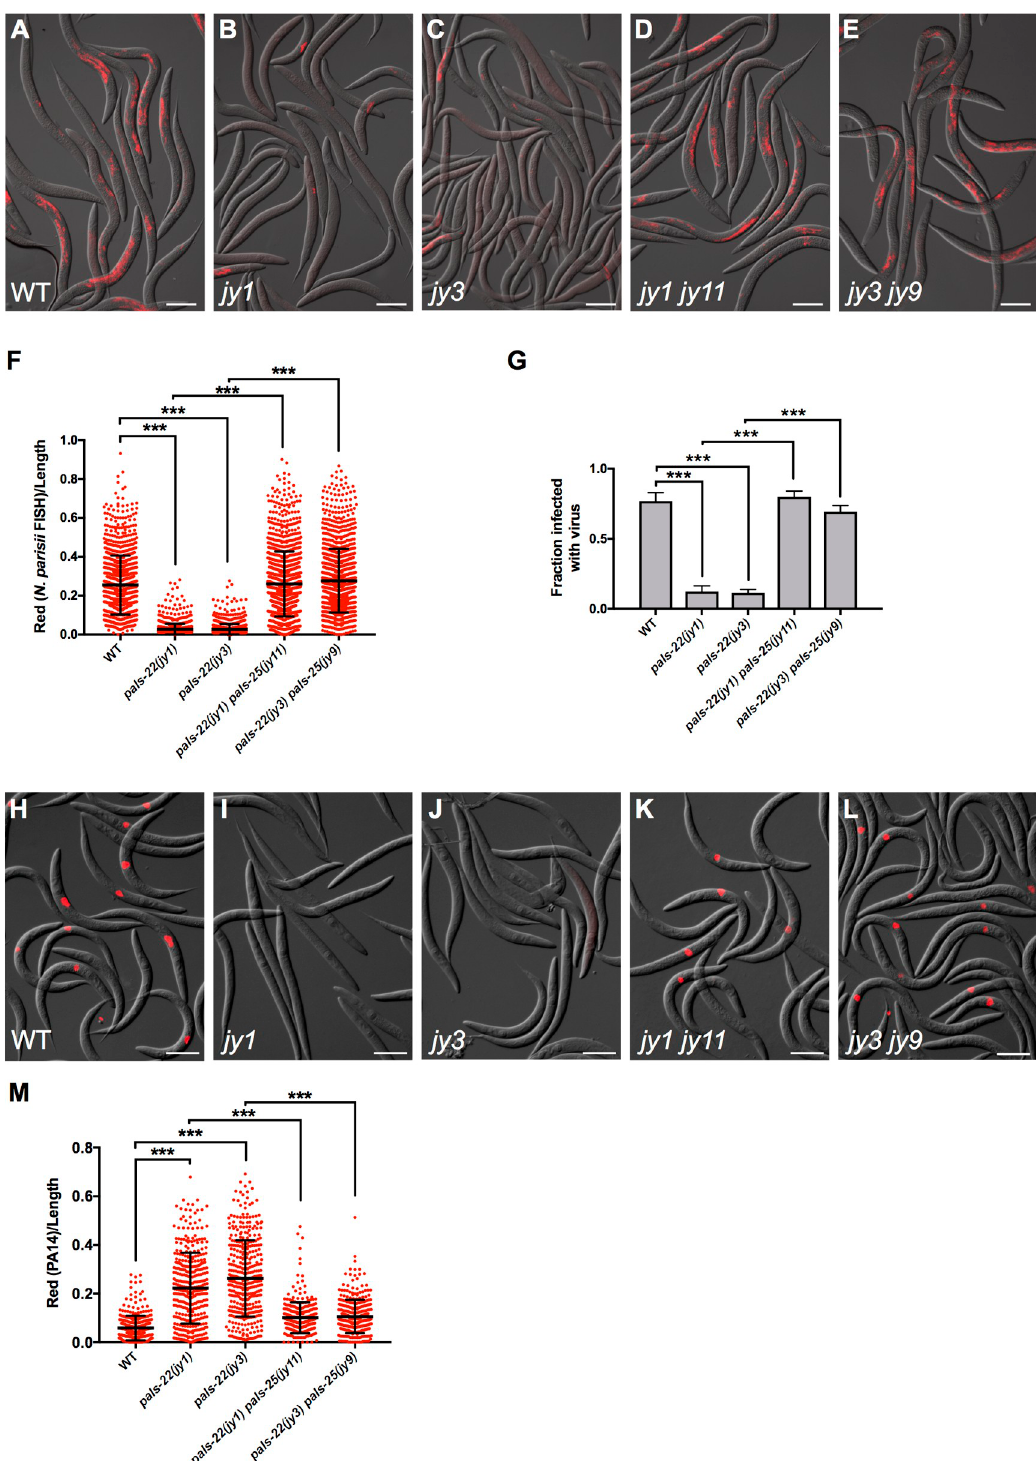
Fig 4. pals-22 mutants have increased resistance to infection by N . parisii or Orsay virus, dependent on pals-25 . (A-E) Images of (A) wild-type, (B) pals-22(jy1) , (C) pals-22(jy3) , (D) pals-22(jy1) pals-25(jy11) , and (E) pals-22(jy3) pals-25(jy9) animals infected with N . parisii as L1s, fixed 30 hours post infection, and stained by FISH with an N . parisii -specific probe (red). Scale bar, 100 μ m. (F) N . parisii FISH signal quantified using a COPAS Biosort machine to measure the mean red signal normalized to the length of individual animals, indicated by red dots. Mean signal of the population is indicated by black bars, with error bars as SD. Graph